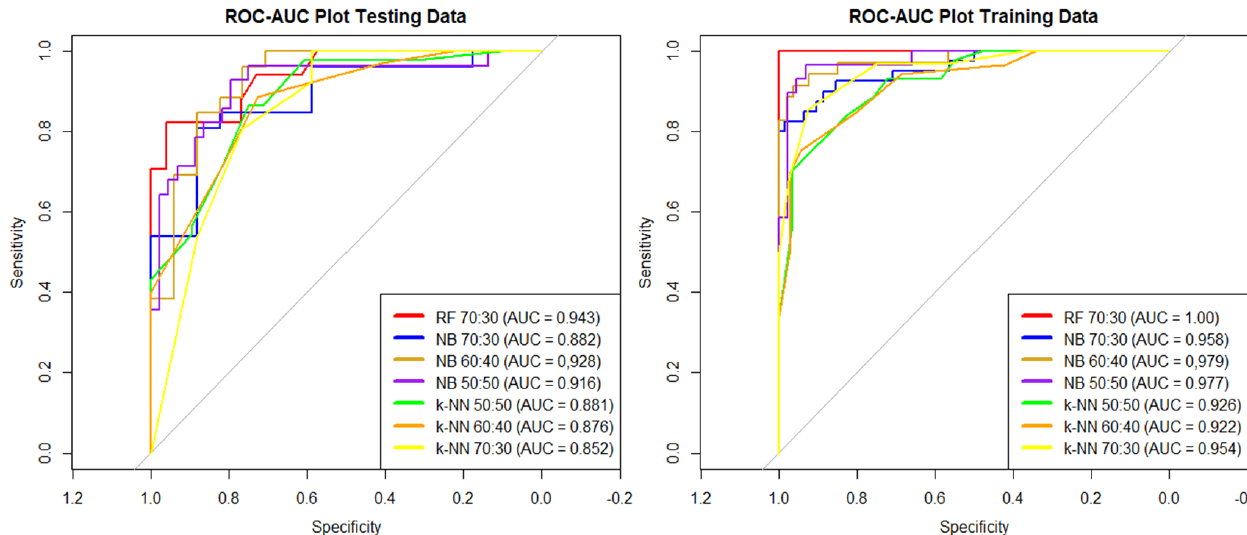
Figure 10. ROC–AUC plot of training and testing data.